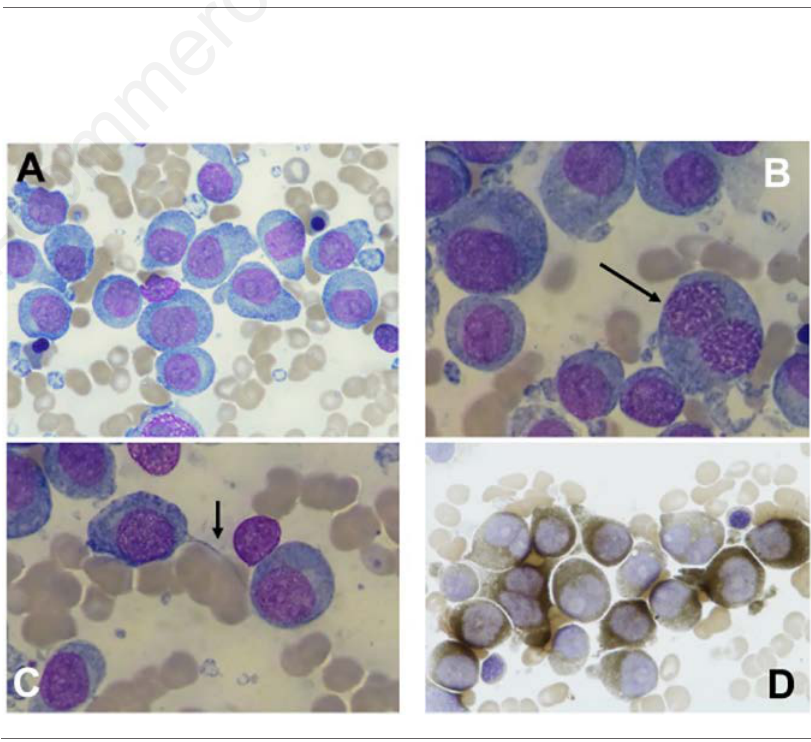
Figure 2. Morphology of myeloaspirate samples. A) massive infiltration by medium- and large-sized blast cells with undifferentiated morphology, often with a perinuclear “hof”. B) a binuclear blast with erythroblast-like morphology (arrow). C) two blast cells linked by a cytoplasmic bridge (arrow). D) most of blast cells are positive for ANAE, with a homogeneous pattern of staining;